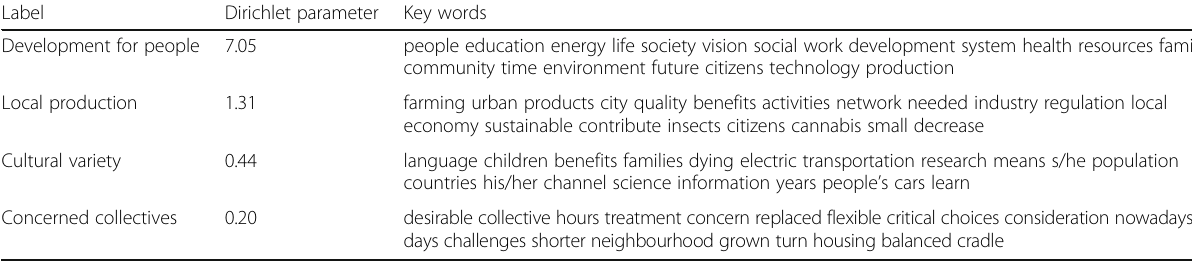
Table 2 Topics in citizen visions in the examined involvement projects